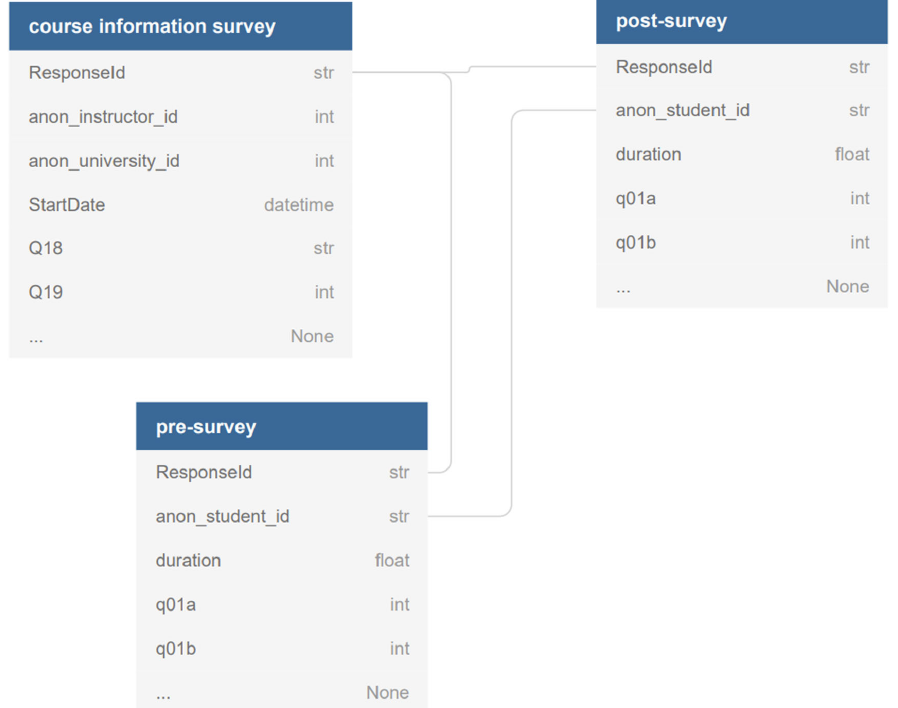
FIG. 4. An abbreviated data schema for the E-CLASS dataset showing a subset of the variable names and type of data (e.g., str for string, int for integer, etc.). The E-CLASS dataset has three tables. The course information table (upper left) contains data for each course that has offered the E-CLASS survey and includes course information such as an estimate of number of enrolled students, level of physics being taught, and institution-level information. The presurvey (lower left), and postsurvey (upper right) responses are located in their respective tables. Student demographic information is asked during the postsurvey and thus is stored in the postsurvey table. A full schema can be found in the Supplemental Material